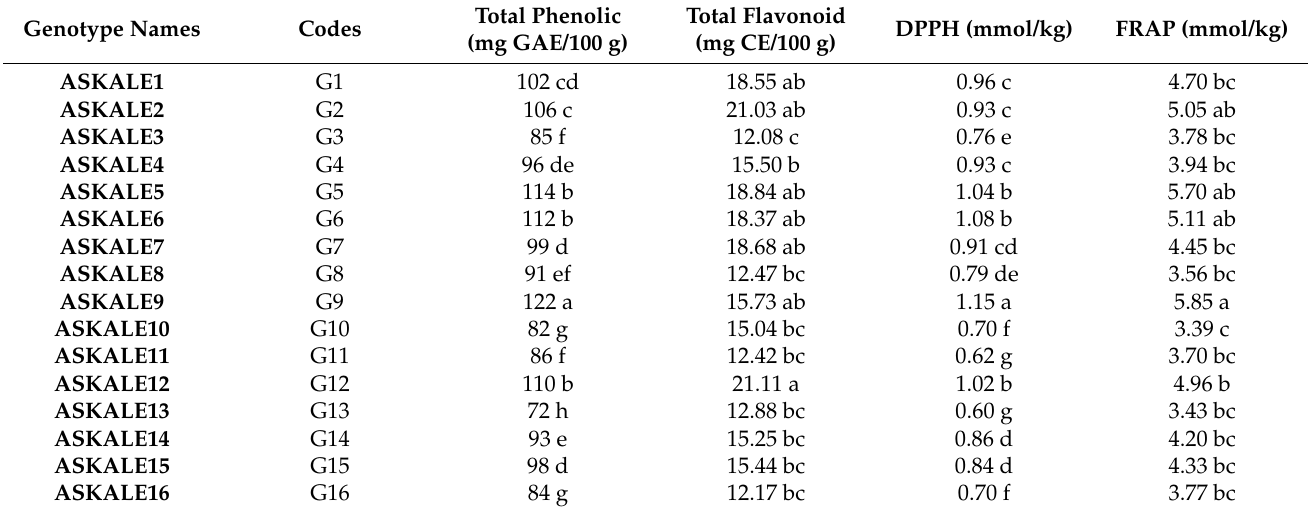
Table 3. Bioctive characteristics of Pyrus elaeagrifolia Pall. subsp. elaeagrifolia